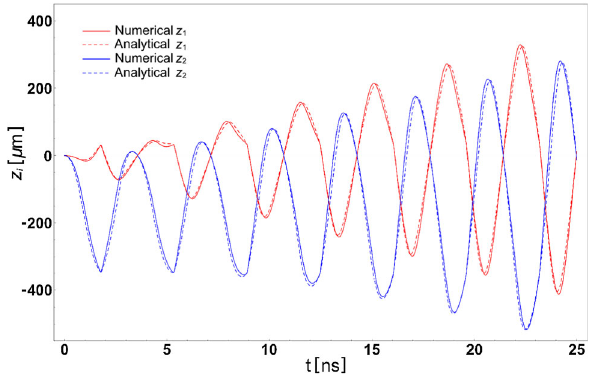
Fig. 7 z 1 and z 2 withrespecttotimevariationobtainedfromanalytical expressions as well as numerical simulation. For illustration, we choose (cid:5) B = ( 0 , 0 , 4 ) T in the lab frame, (cid:2) = 500 eV, quirks have charges of ± e and m = 100 GeV, (cid:5) P = ( − 279 . 6 , 250 . 7 , 4 . 8 ) GeV, and (cid:5) P o 1 ( − 36 . 5 , 102 . 5 , 303 . 6 )